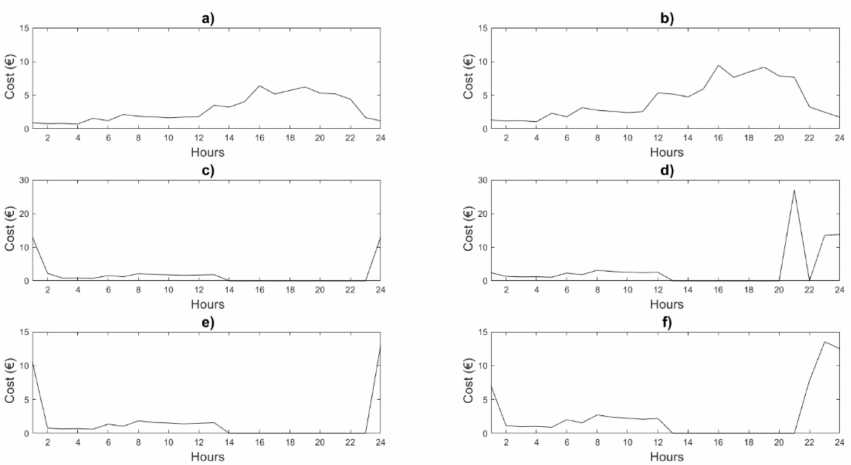
Figure 4. Total electricity costs for specific months of the year, by hours, for each system: ( a ) Current AC system on June. ( b ) Current AC system on December. ( c ) AC system with battery on June. ( d ) AC system with battery on December. ( e ) Combined AC / DC system with battery on June. ( f ) Combined AC / DC system with battery on December.